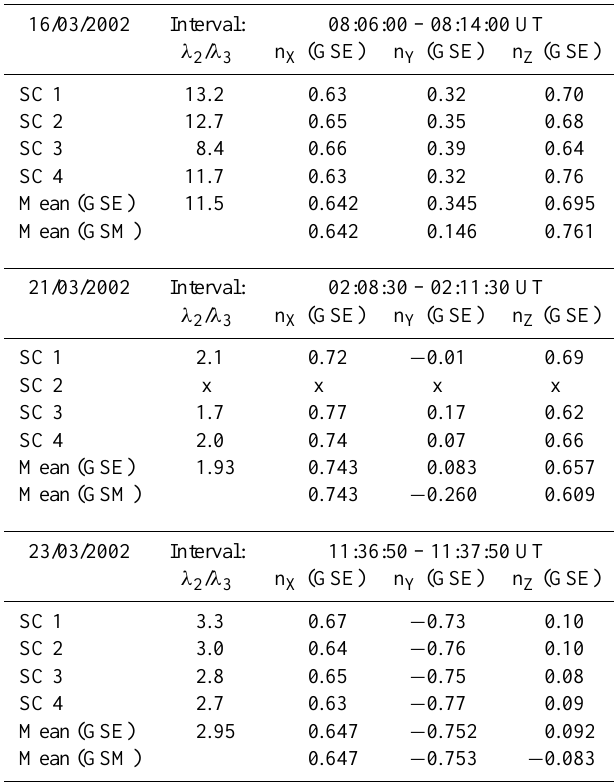
Table 1. This table presents the results arising from the applica- tion of the Minimum Variance Analysis (MVA) technique on the SEC/Magnetosheath boundary for the three events and for the four spacecraft in GSE coordinates (no data is available on SC 2 on 21/03/2002). The data interval used for the analysis is given. The ratio of minimum to intermediate eigenvalues is given for each spacecraft, as well as the average. The average normal direction is also given, both in GSE and GSM